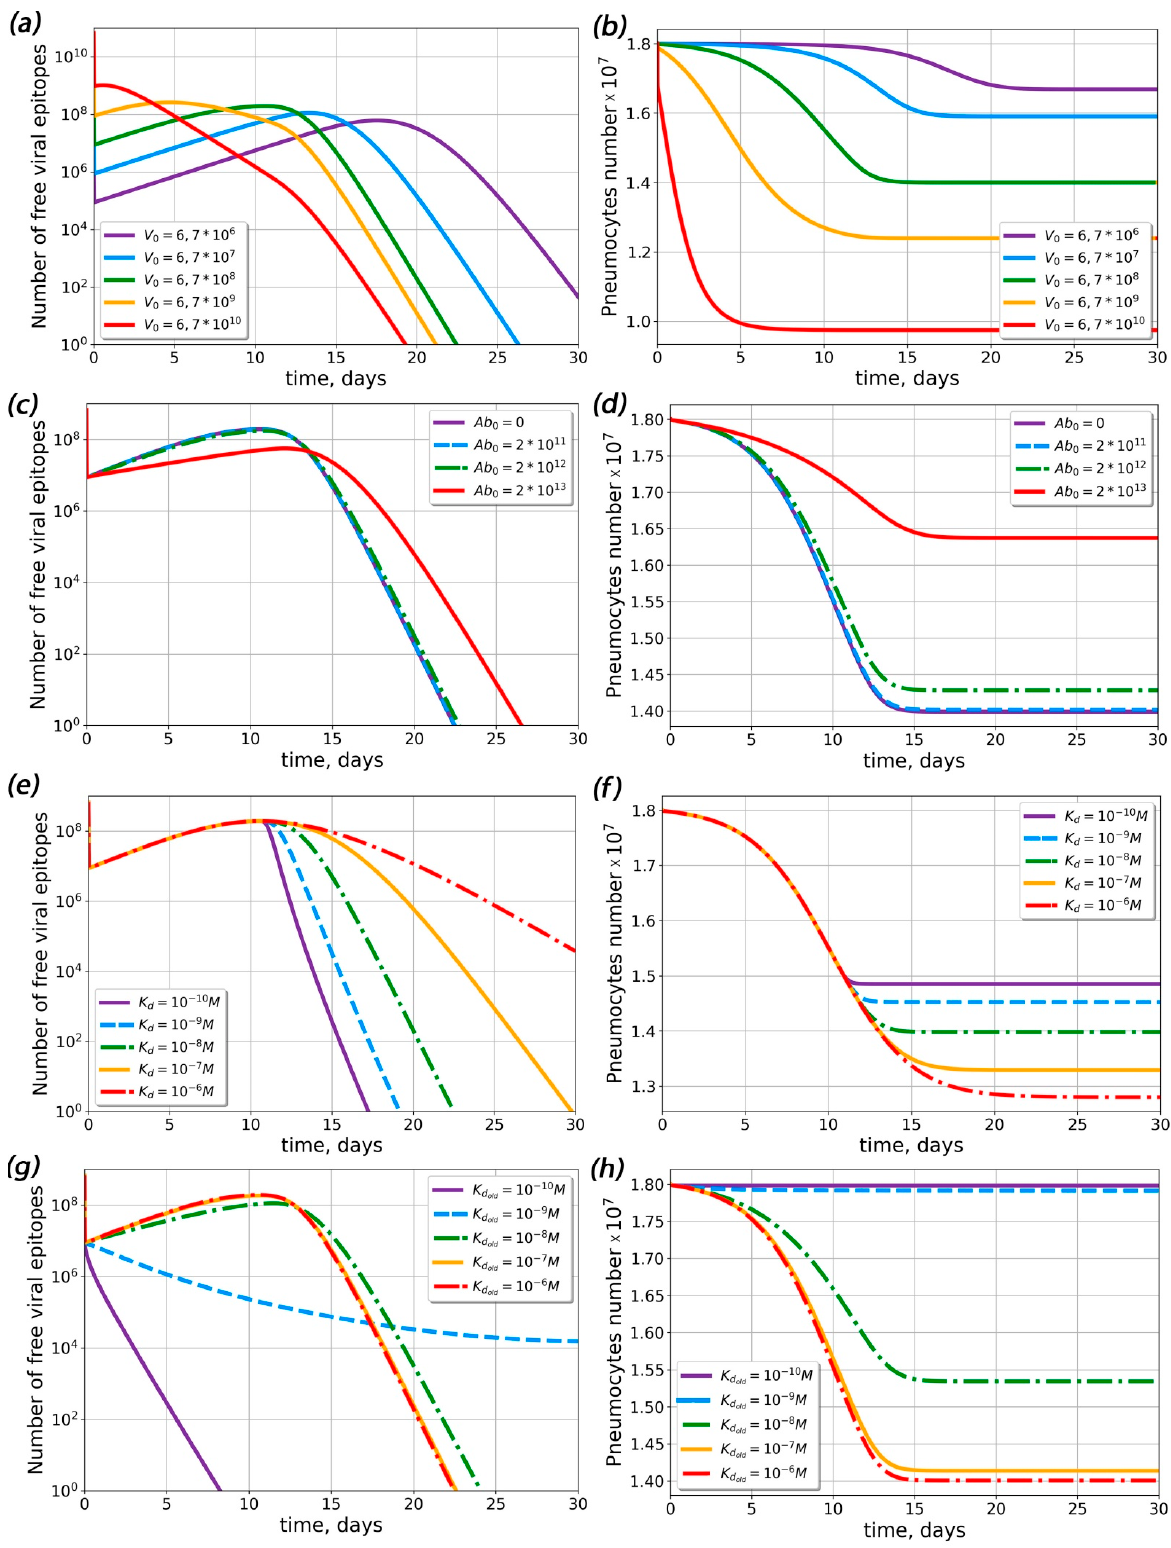
Figure 2. Influence of initial viral load, pre-existing antibody concentration and dissociation constant of the antigen–antibody complex (Kd) on the free viral epitope and pneumocyte dynamics in the complete model. ( a , b ) Dynamics of free viral epitope ( a ) and pneumocytes ( b ) at various initial viral